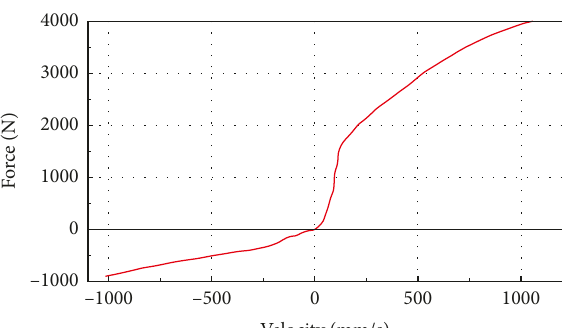
Figure 4: Shock absorber speed-damping force